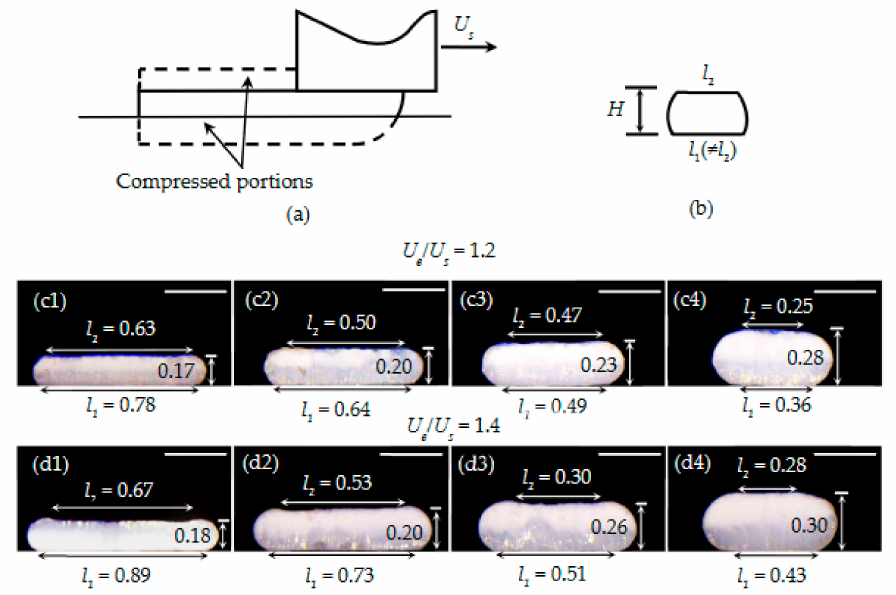
Figure 6. ( a ) Illustration of Case II.2. ( b ) Cross-sectional view of a compressed strand. ( c1 – d4 ) Represen- tative cross-sections of the deposited strands, when the U e /U s ratios are 1.2 and 1.4 at different nozzle heights. Scale bar: 0.25